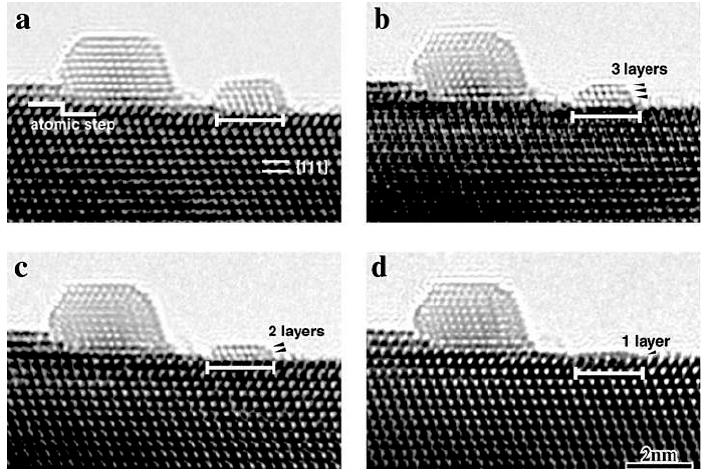
Figure 19. Series of high-resolution TEM revealing the shrinking process of an Au nanoparticle supported on CeO 2 solely induced by e-beam illumination: ( a ) one large and one smaller Au nanoparticles can be observed; the smaller nanoparticle shrinks layer by layer ( b ) 3 remaining layers; ( c ) 2 remaining layers; ( d ) 1 remaining layer. Reprinted from [240]. Copyright 2005, Springer.